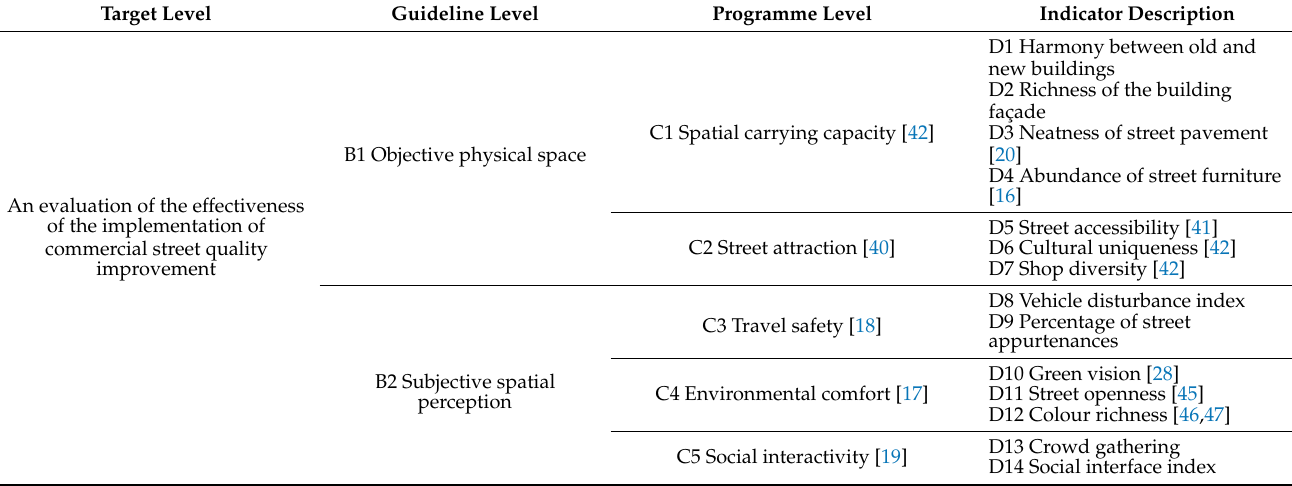
Table 1. Indicator system for evaluating the effectiveness of implementing quality improvement in commercial